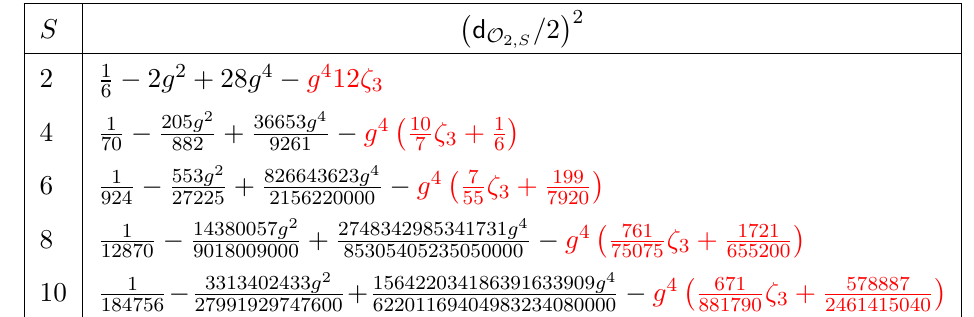
Table 3 . Length-stripped structure constants bers colored in black coincide with the asymptotic hexagon formula while the numbers colored in red coincide with the bottom wrapping